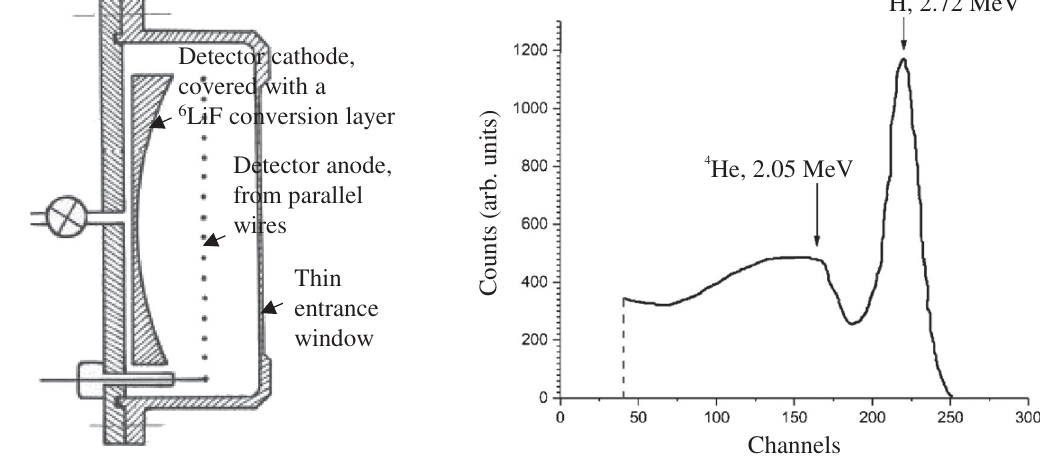
FIG. 2. Left: Scheme of the detector designed for the TOF device (side view). Right: Amplitude spectrum of the detector output signal (in a.u.). The two peaks correspond to the detection of 4 He (2.05 MeV) and 3 H (2.72 MeV) from neutron capture in 6 Li. The lowest amplitudes are cut by a discriminator.